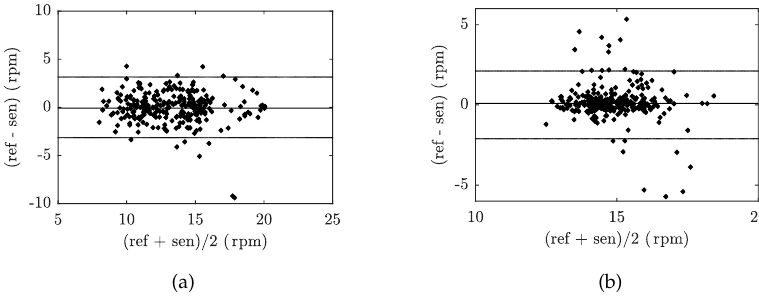
Figure 12. Reproducibility of RR determination capabilities of our FBG sensor (based on comparison with Pneumatic Respiratory Transducer-based RR calculations) using the Bland–Altman method for the data acquired from: ( a ) volunteer M1, and ( b ) volunteer